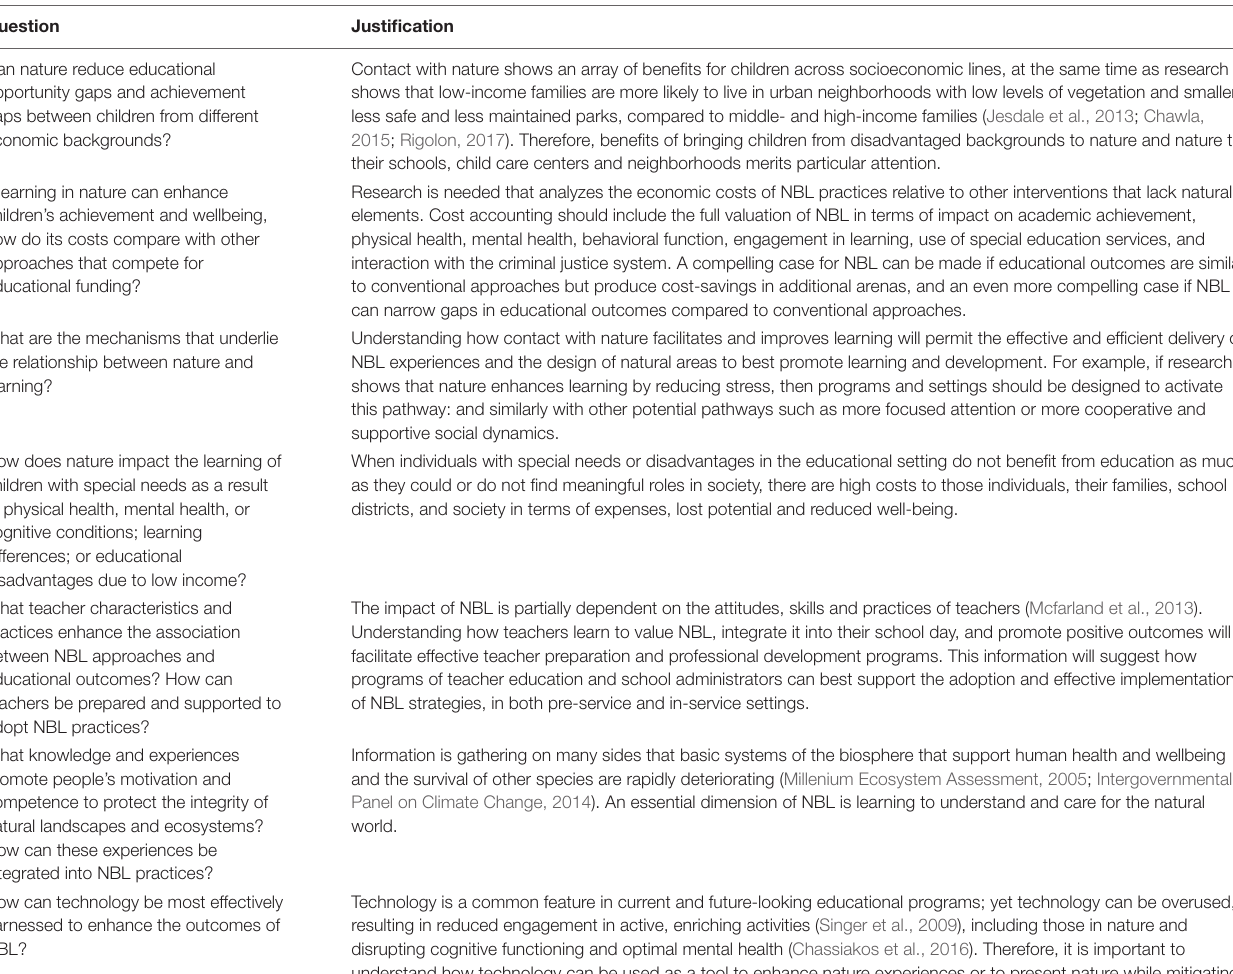
TABLE 2 | Examples of “game-changing” research questions and justifications. Question